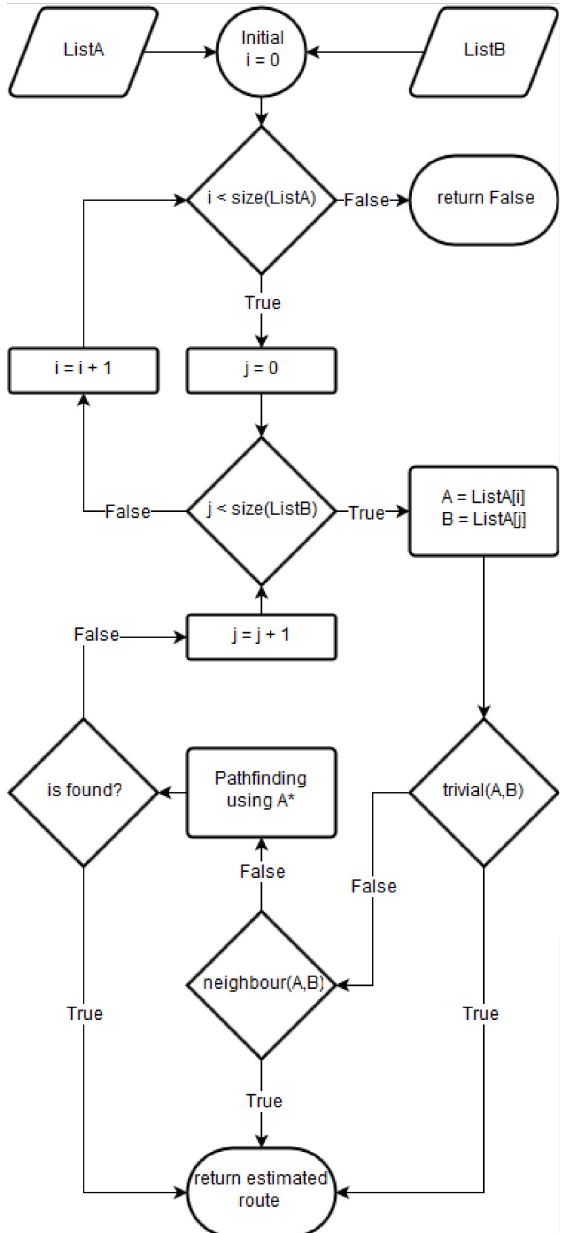
Figure 6. Flow diagram of the route estimating